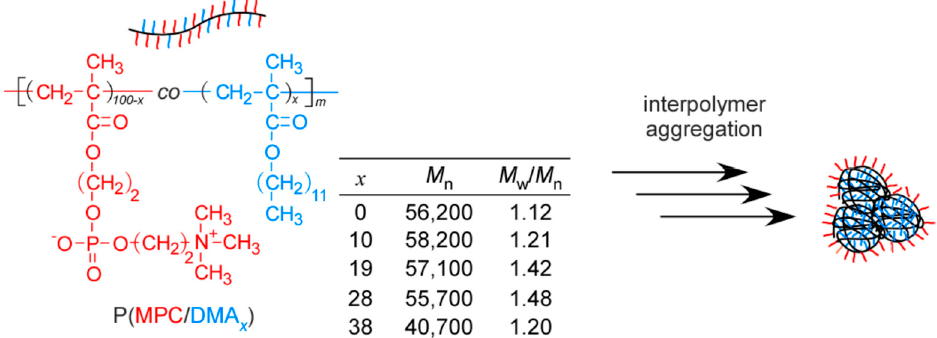
Figure 1. Chemical structure of the random copolymer (P(MPC/DMA x )) and a conceptual illustration of interpolymer aggregation.